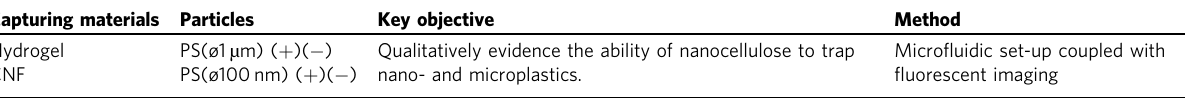
Table 2 Nanocellulose hydrogels trap nano- and microplastic particles. Capturing materials Particles